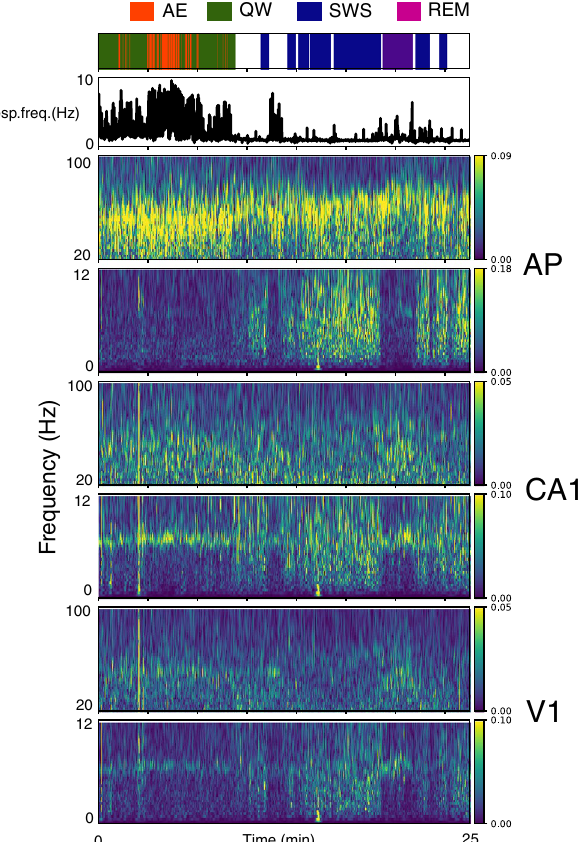
Figure 1. Example of a 25 min long recording in anterior piriform cortex (AP), hippocampus CA1 and primary visual cortex (V1) regions. Top panel: states scoring with active exploration (AE, red), quiet awaking (QW, green), slow-wave sleep (SWS, blue), and rapid-eye movements sleep (REM, pink). Periods not scored (not all criteria met, see “Methods”) appear in white. Second panel: Instantaneous respiratory frequency (in Hz). Other panels from top to bottom: For each structure (AP, CA1, V1), time–frequency representation of LFP in the low (0.5–12 Hz) and high (20–100 Hz) frequency range. Warm colors indicate high